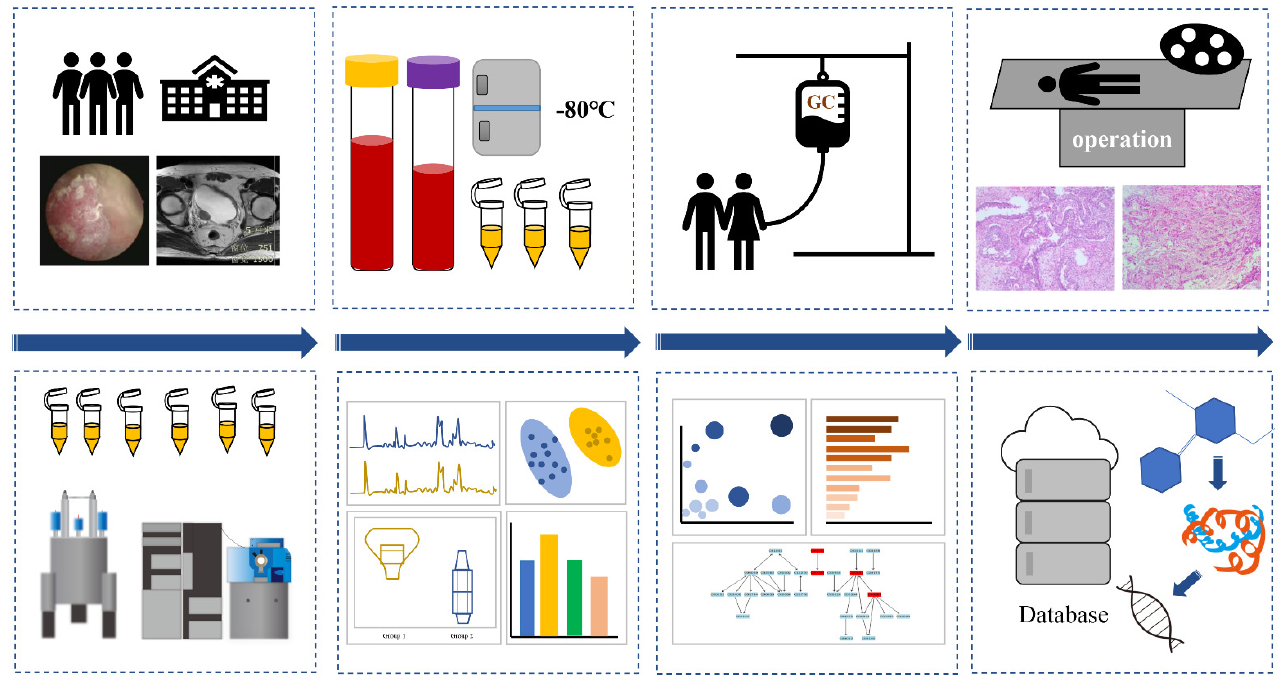
Figure 7. Workflows of this study, including the treatment of MIBC patients and the process of serum metabolomics.